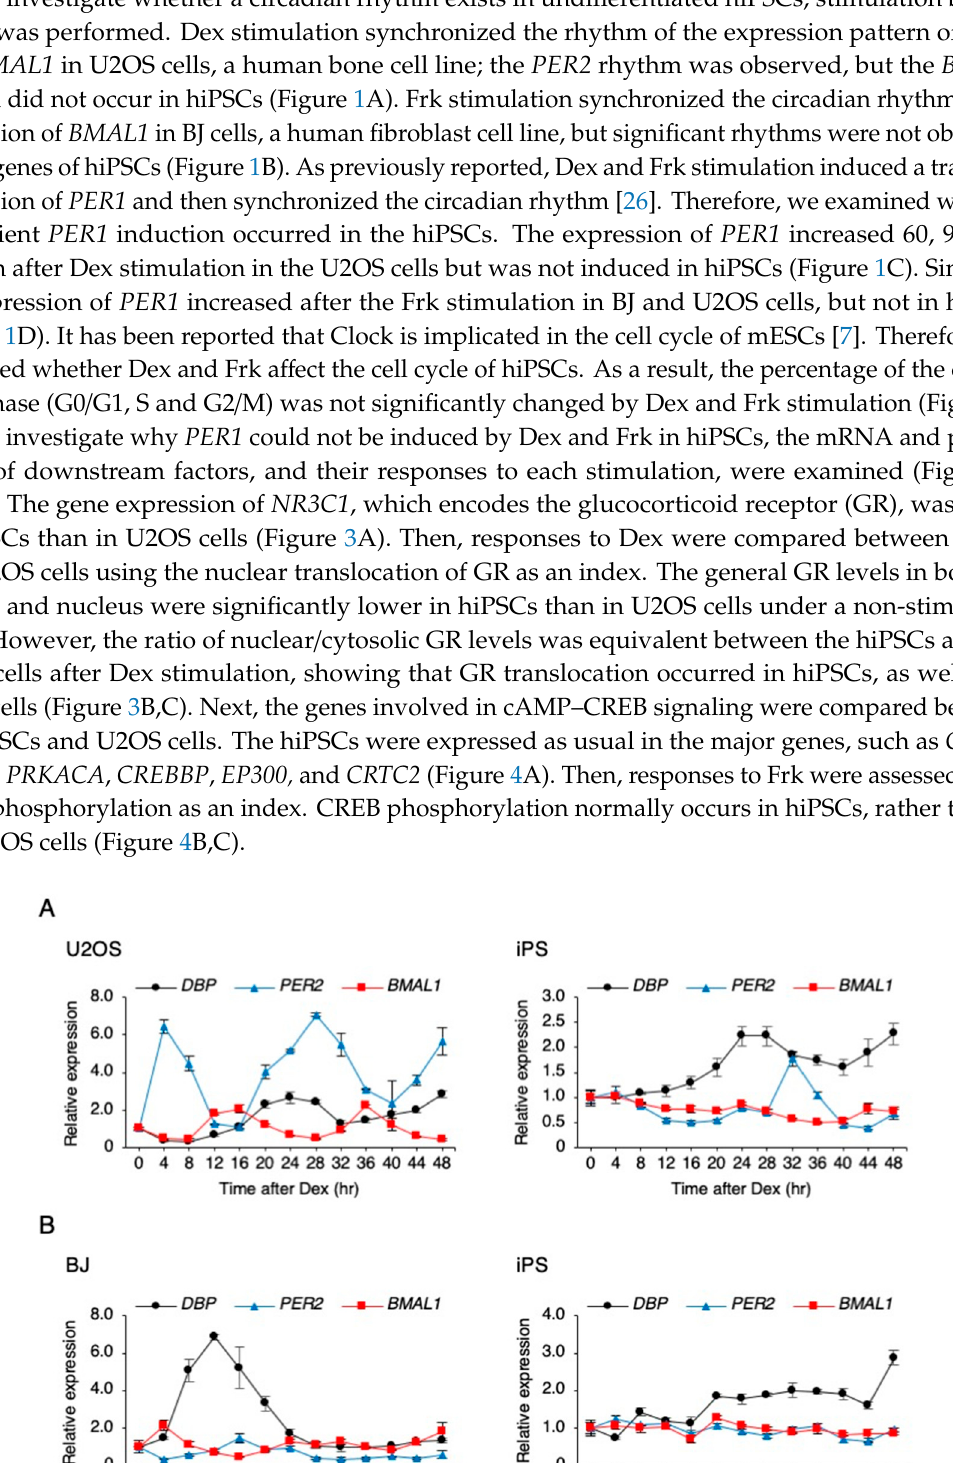
Figure 1. The response of clock genes to synchronizing stimulations in human-induced pluripotent stem cells (hiPSCs). ( A ) The expression levels of clock genes every 4 h after dexamethasone (Dex) stimulation in U2OS cells and hiPSCs. Data are presented as the means ± SEM relative to 0 h; n = 3 for each comparison. P values for the rhythmicity of DBP , PER2 , and BMAL1 were determined by a cosinor analysis as p = 0.08, p = 0.02, and p < 0.01 in U2OS cells, and p = 0.54, p = 0.03, and p = 0.11 in hiPSCs. ( B ) The expression levels of clock genes every 4 h after forskolin (Frk) stimulation in BJ cells and hiPSCs. Data are presented as the means ± SEM relative to 0 h; n = 3 for each comparison. p values for the rhythmicity of DBP , PER2 , and BMAL1 were determined by a cosinor analysis as p = 0.26, p = 0.29, and p = 0.02 in BJ cells, and p = 0.89, p = 0.21, and p = 0.59 in hiPSCs. ( C ) The expression level of PER1 after treatment with 0.1 µM Dex in U2OS cells and hiPSCs. Data are presented as the means ± SEM relative to each 0 h. n = 3 for each comparison. ** p < 0.01 versus the corresponding control. ( D ) The expression level of PER1 after treatment with 10 µM Frk in BJ, U2OS cells, and hiPSCs. Data are presented as the means ± SEM relative to each 0 h; n = 3 for each comparison. * p < 0.05, ** p < 0.01 versus the corresponding control.